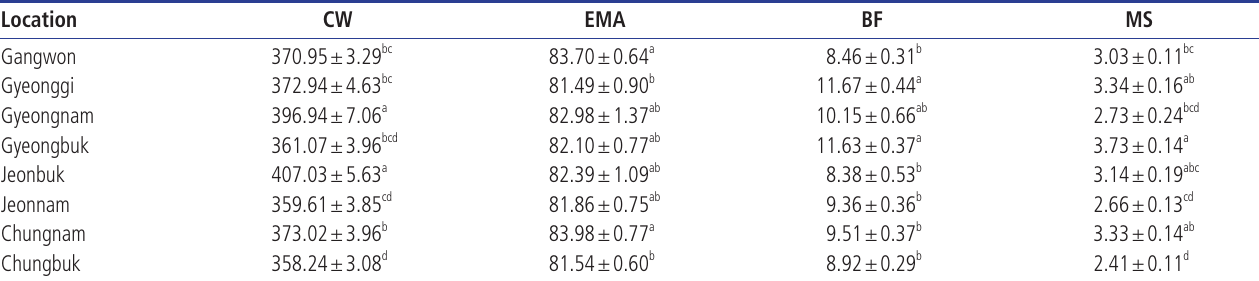
Table 6. Least squares means and standard errors of traits by location Location CW